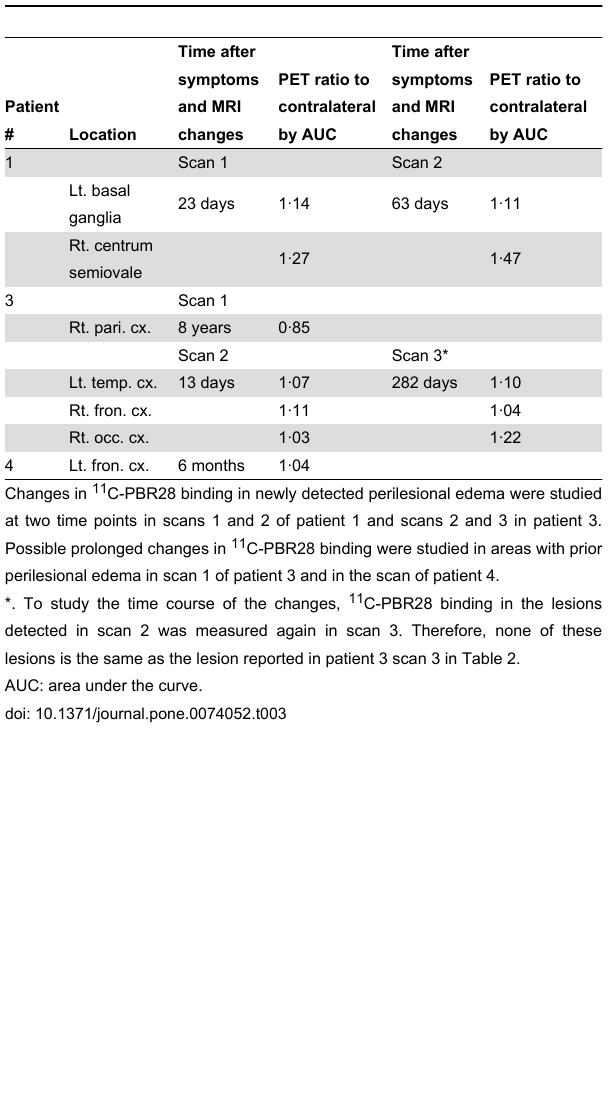
Table 3. Time course of the changes in 11 C-PBR28 binding in patients who showed perilesional